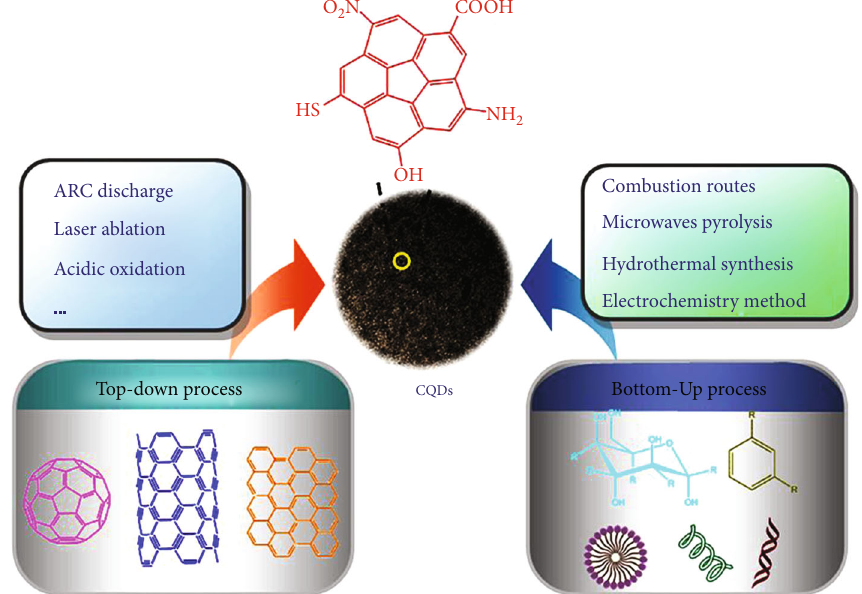
Figure 1: Types of preparation of carbon quantum dots.